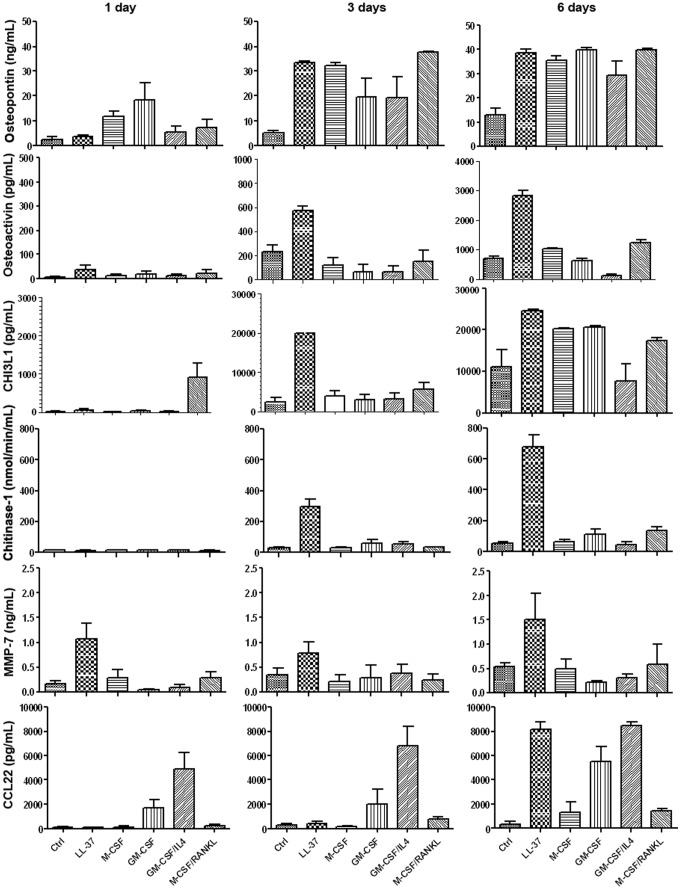
Monoosteophils release high level of osteopontin, osteoactivin, cartilage glycoprotein-39, chitinase 1, MMP-7 and CCL22.Monocytes were incubated in the absence or presence of LL-37 (5 µM), GM-CSF (20 ng/mL), GM-CSF+IL-4 (both 20 ng/mL), M-CSF (50 ng/mL) or M-CSF +RANKL (both at 25 ng/mL) for 1, 3 or 6 days. Supernatants were harvested and proteins were detected by using ELISA Kits (n = 3). CHI3L1: cartilage glycoprotein-39.